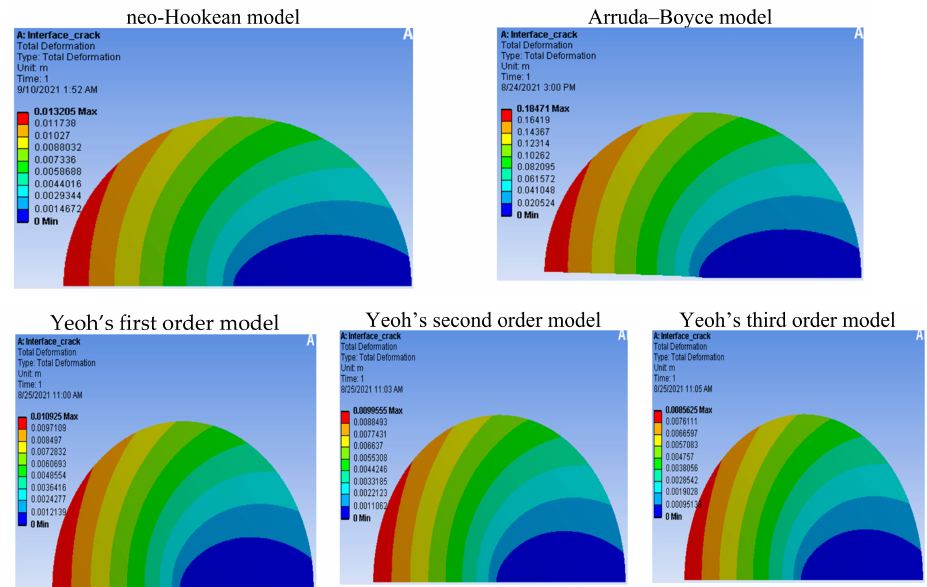
Figure 9. Contours of the deformation in the y direction (m).